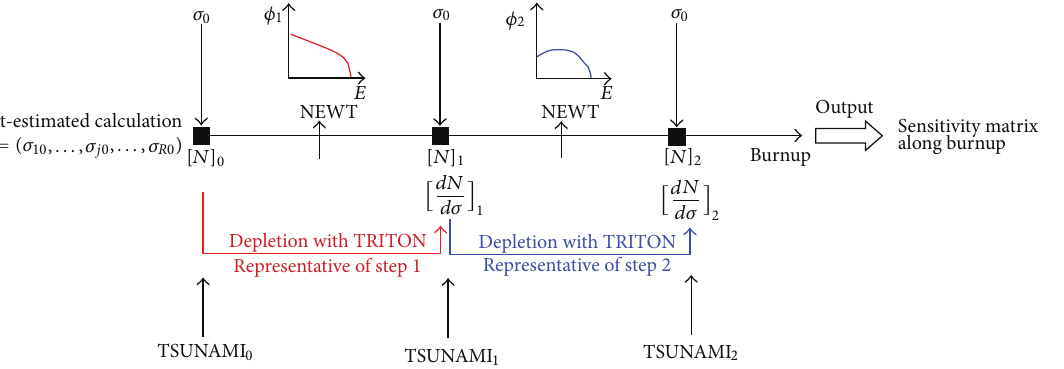
F 3: Procedure based on